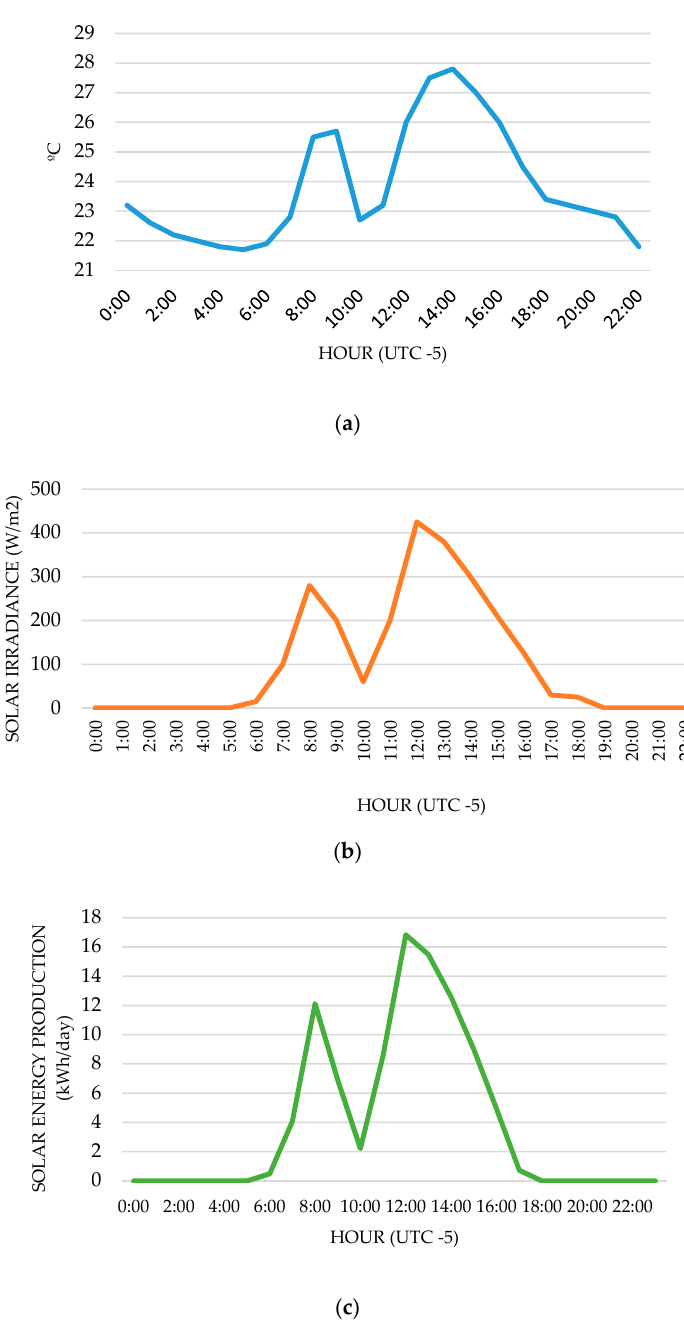
16 of 24 Figure 9. ( a ) Ambient temperature, ( b ) solar irradiance and ( c ) energy generated by the PV system on September 18th (time in hours corresponding to UTC-5).